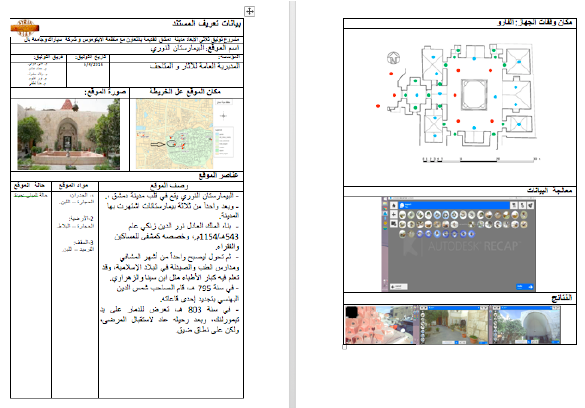
Figure 1. Screen capture of sample DGAM meta-data form